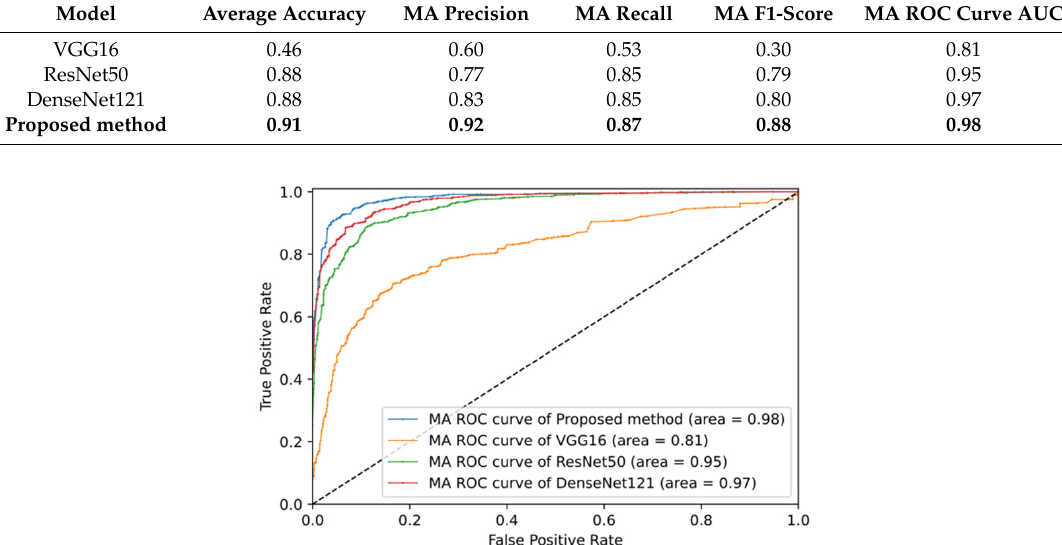
Figure 10. Macro-averaged ROC curves scores for all CNN models.